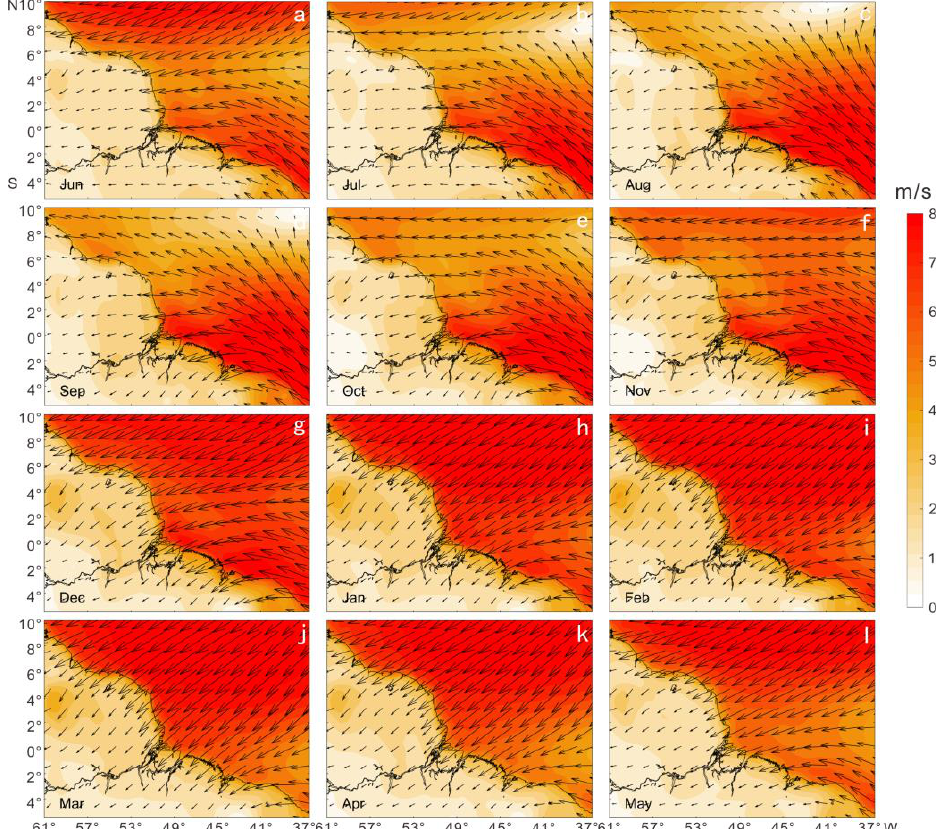
Figure 5. Monthly average wind field over 10 years in the study area off the Amazon estuary (2008 – 2017). ( a – l ) correspond to the winter period (June – November) and summer period (December – May) in the southern hemisphere, respectively (unit: